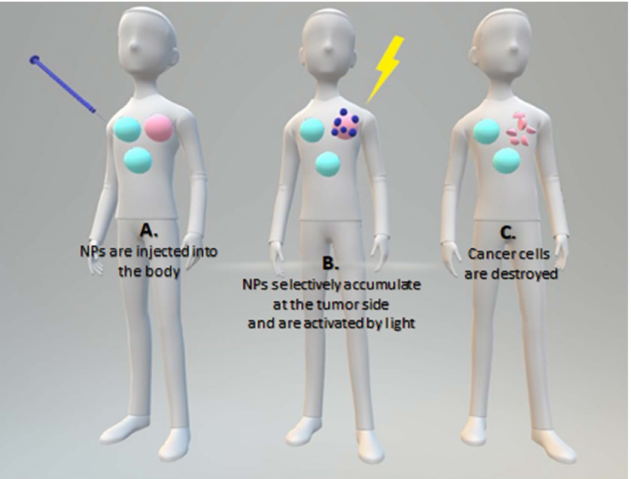
Scheme 1. Schematic illustration of the photodynamic action with Pc-NPs in cancer cells (in pink: cancer cells; in aquamarine: health cells; in indigo: